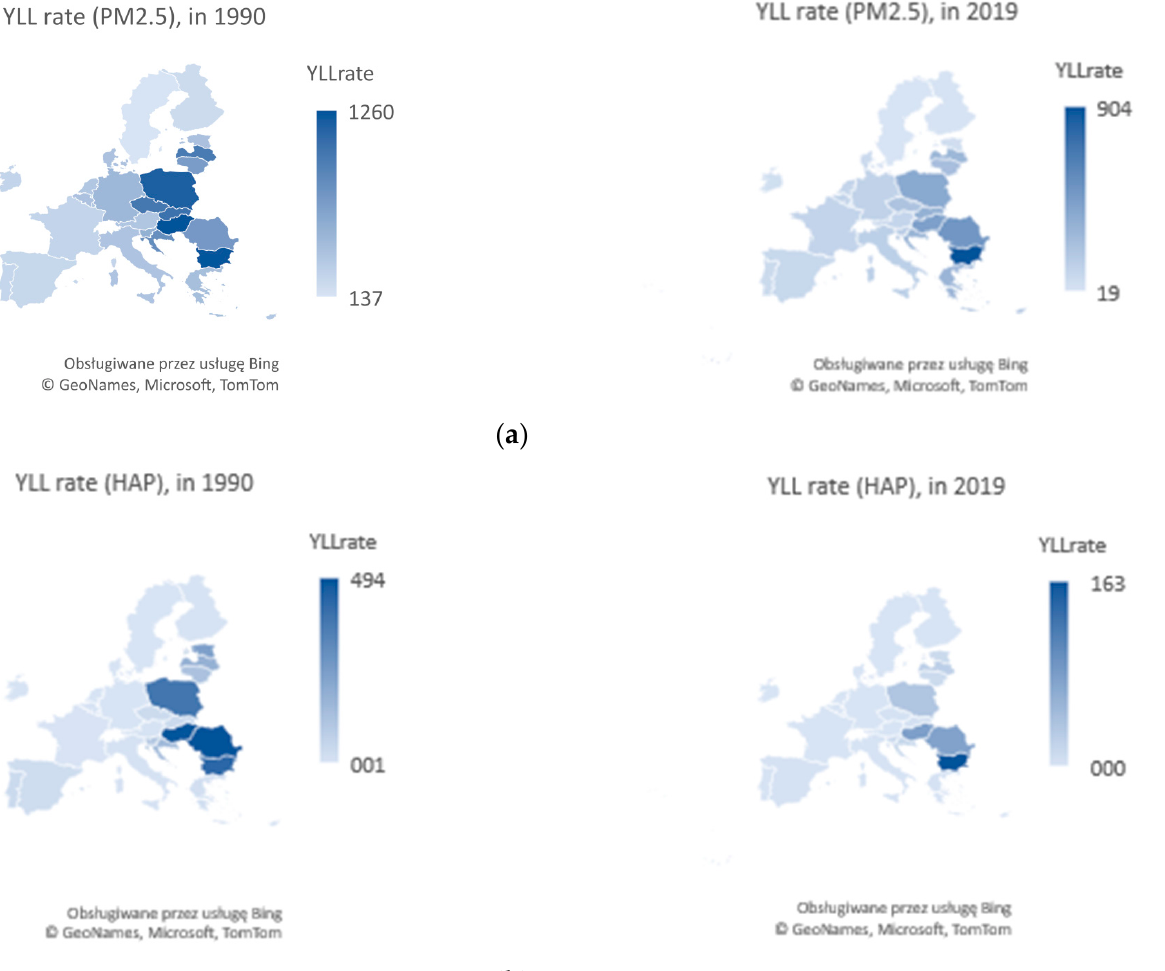
Figure 3. Spatial distribution of parameters YLL rate, population aged 20–54 (EU-27, in 1990 and 2019). ( a ) Ambient particulate matter pollution (PM2.5). ( b ) Household air pollution from solid fuels (HAP).